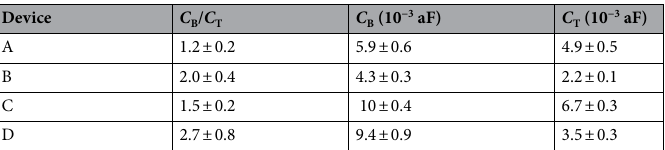
Table 1. Averaged values of C B / C T , C B , and C T for four devices. C B / C T and C B contains the reading error of the slope and period of the current peak line, respectively. C T was evaluated by using the values of C B / C T and C B .